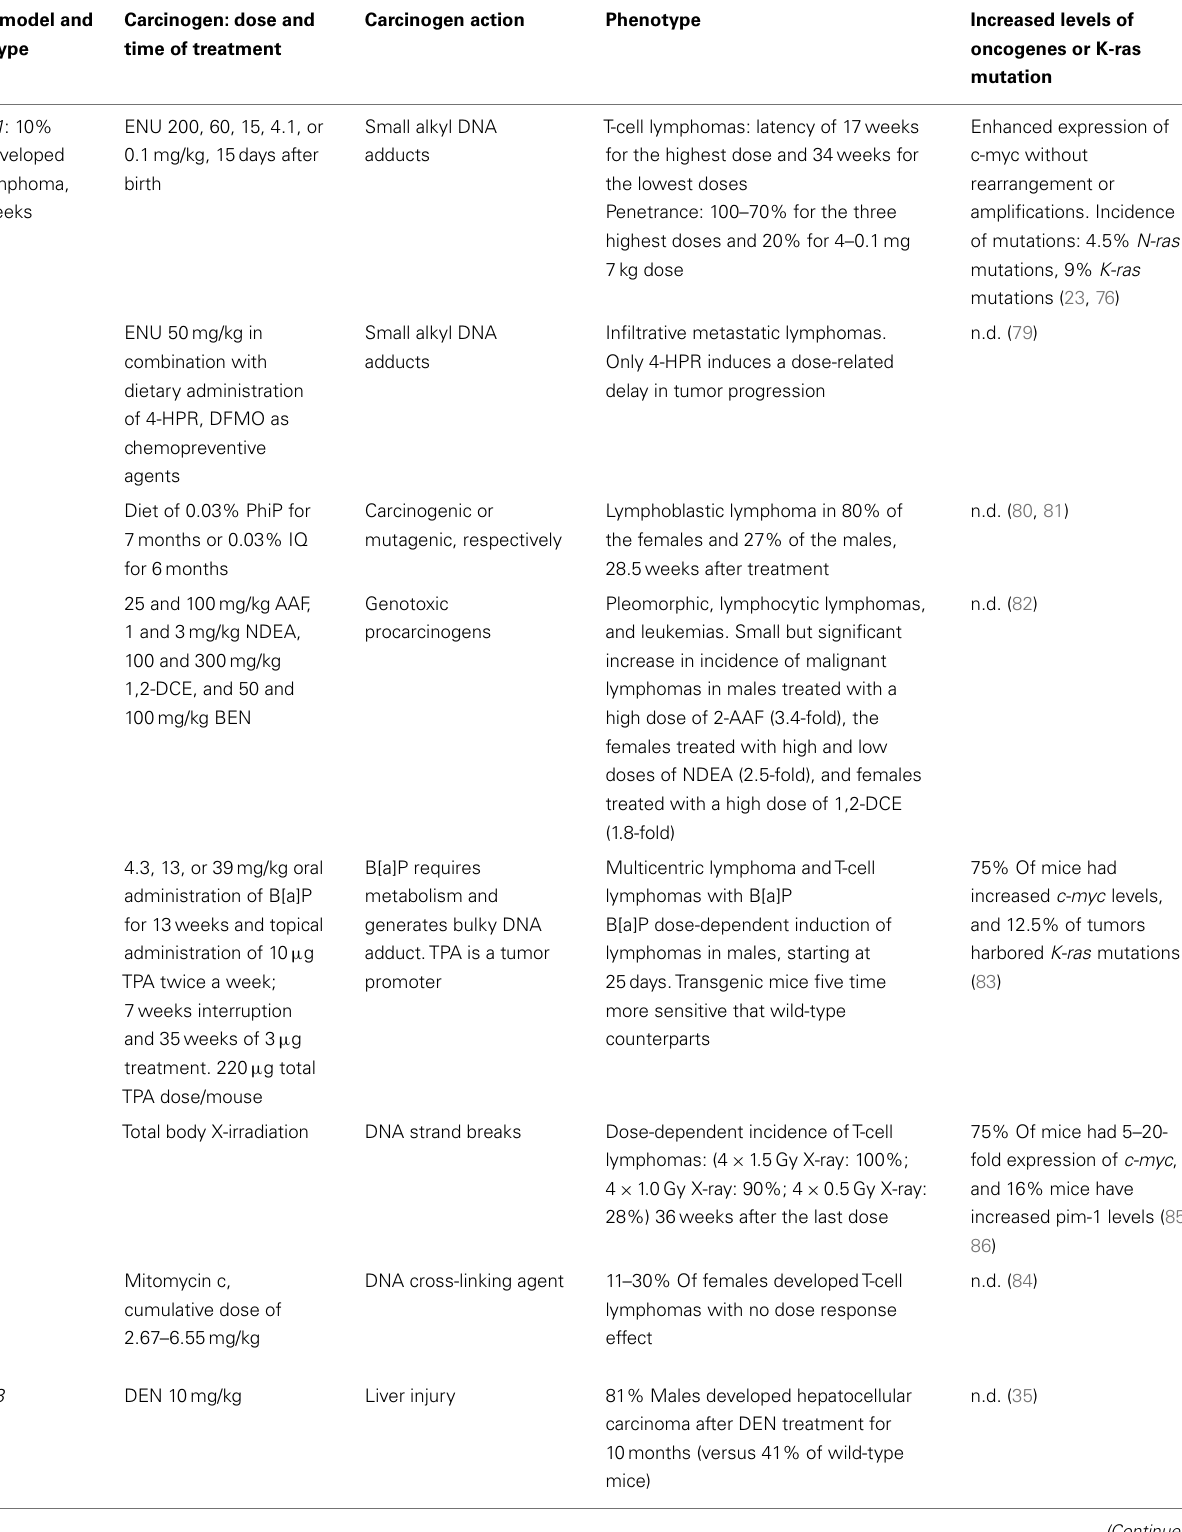
Table 6 | Carcinogens strongly induce tumorigenesis in Pim mouse models